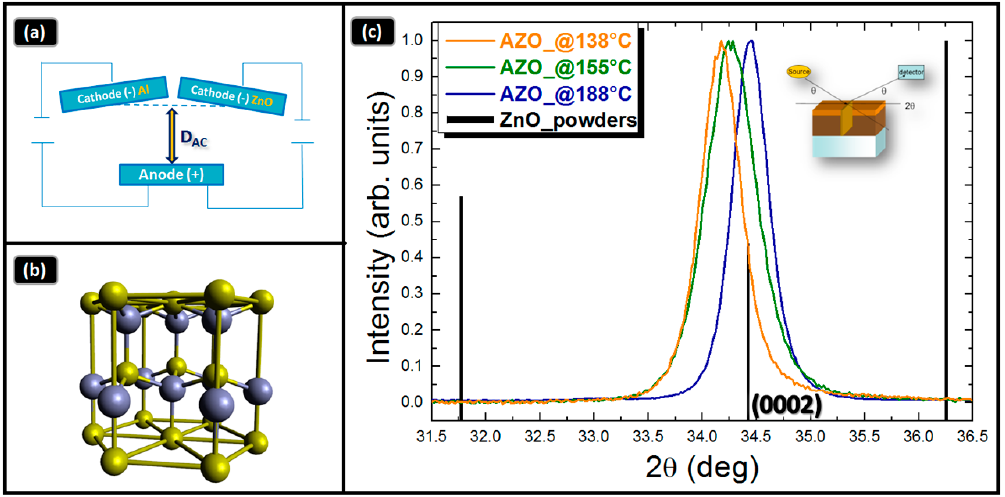
Figure 1. ( a ) Schematic of the co-focal geometry; ( b ) Wurtzite structure; and ( c ) 2 θ - ω X-ray diffraction (XRD) patterns of different Al doped ZnO (AZO) samples deposited at low temperature (T < 200 °C).